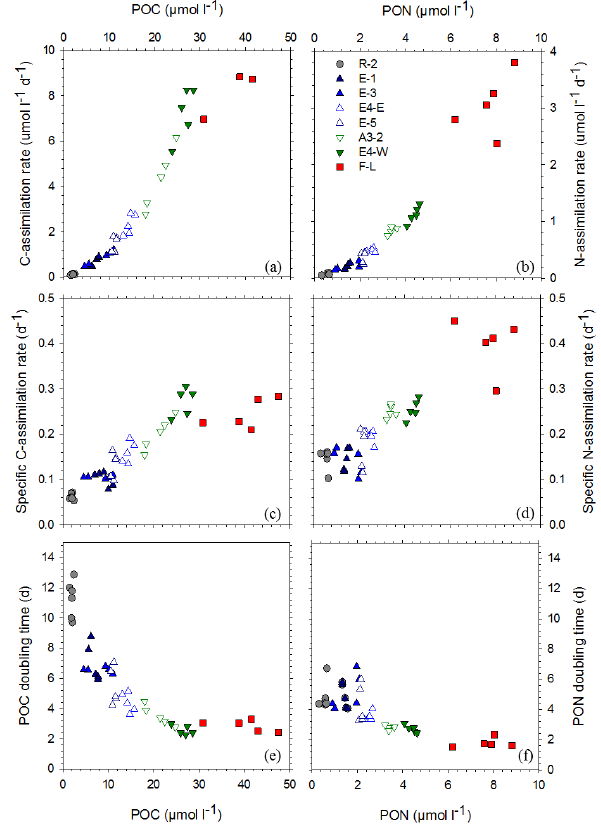
Figure 3. Euphotic layer (100 to 1% PAR) relationship be- tween (a) POC and NPP, also called the C-assimilation rate (µmolCm − 2 d − 1 ) ; (b) PON (µmolL − 1 ) and N-assimilation rates (µmolNm − 2 d − 1 ) ; (c) POC and specific C-assimilation rate (growth rate; d − 1 ) ; (d) PON and specific N-assimilation rate (growth rate; d − 1 ) ; (e) POC and POC doubling time; (f) PON and ] ver- PON doubling 4